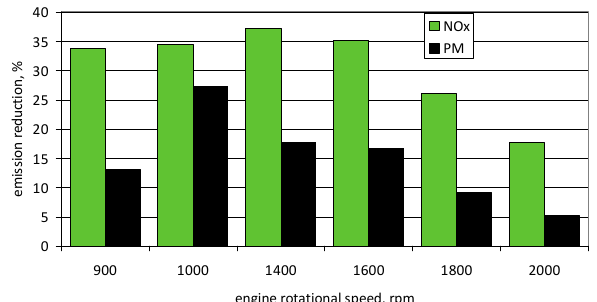
Fig. 29. Possibilities to emission reduction of NO x and PM thru advanced exhaust gas cooling